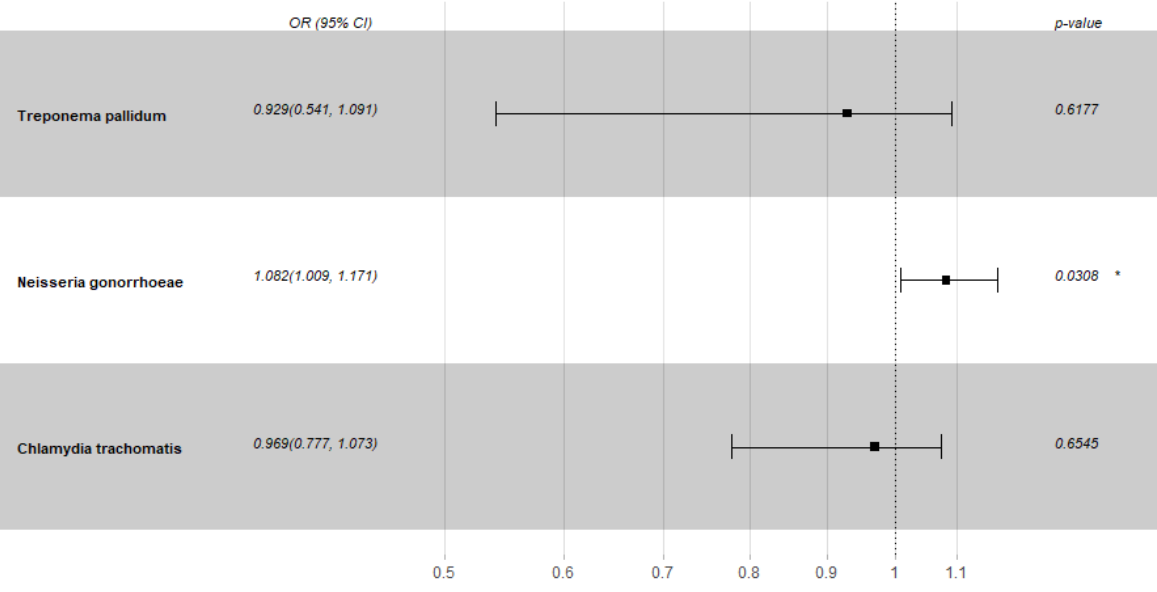
Figure 2. Neisseria gonorrhoeae , Chlamydia trachomatis and Treponema pallidum risk of infection in the studied group dependent on the number of sexual partners—first timepoint. * p < 0.05.